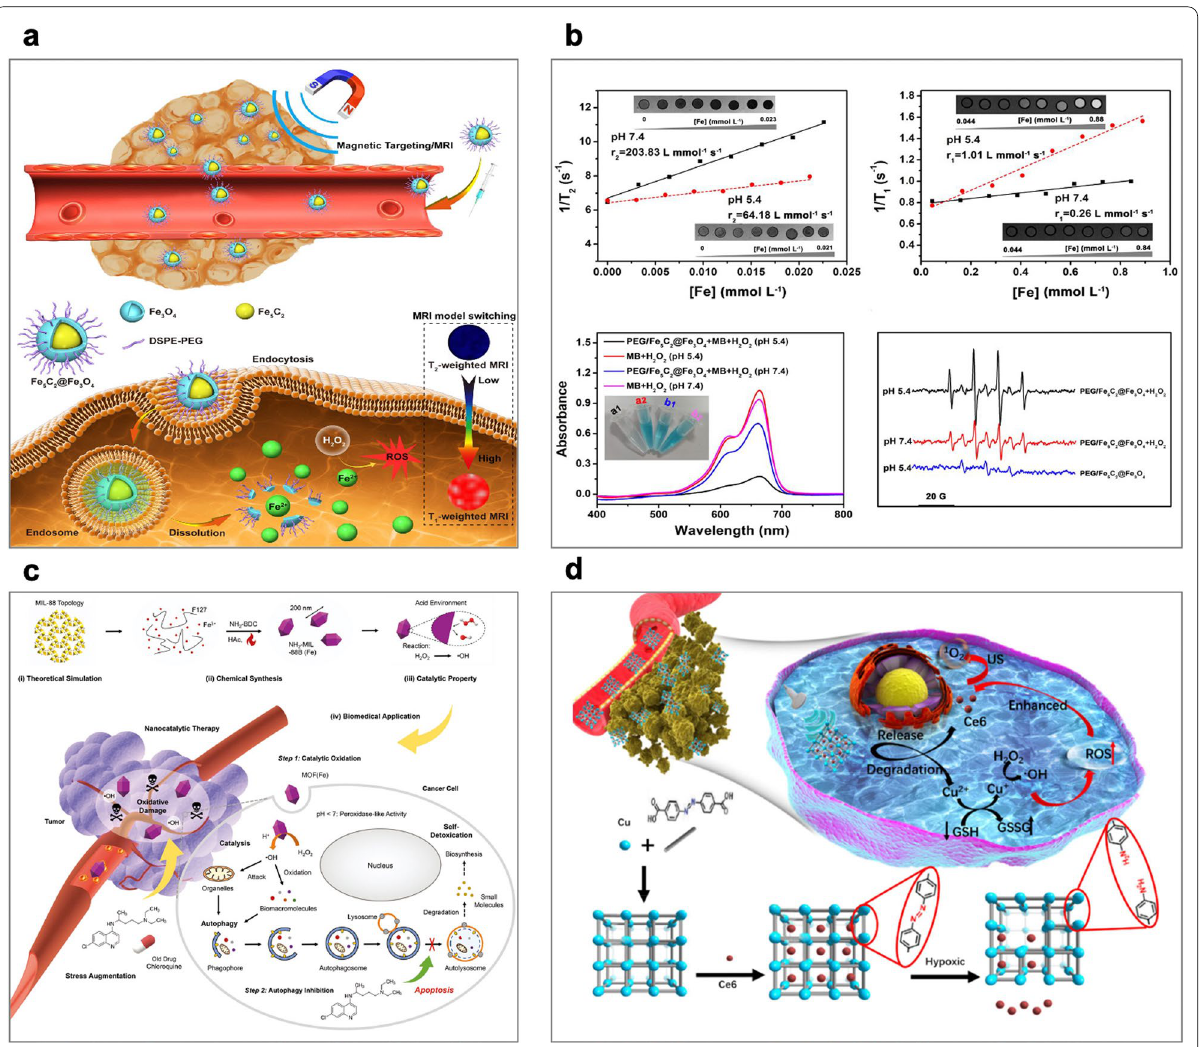
Fig. 5 a A diagram of Fe 5 C 2 @Fe 3 O 4 NPs for pH-responsive Fe 2 + releasing, ROS generation and T2/T1 signal conversion. b pH-dependent MRI model switching of